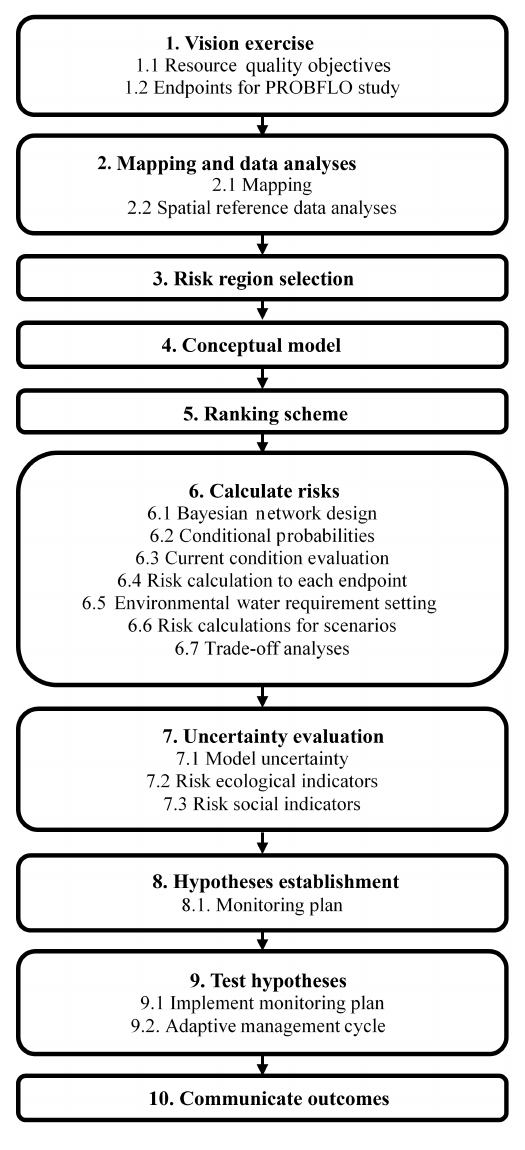
Figure 3. The 10 procedural steps of